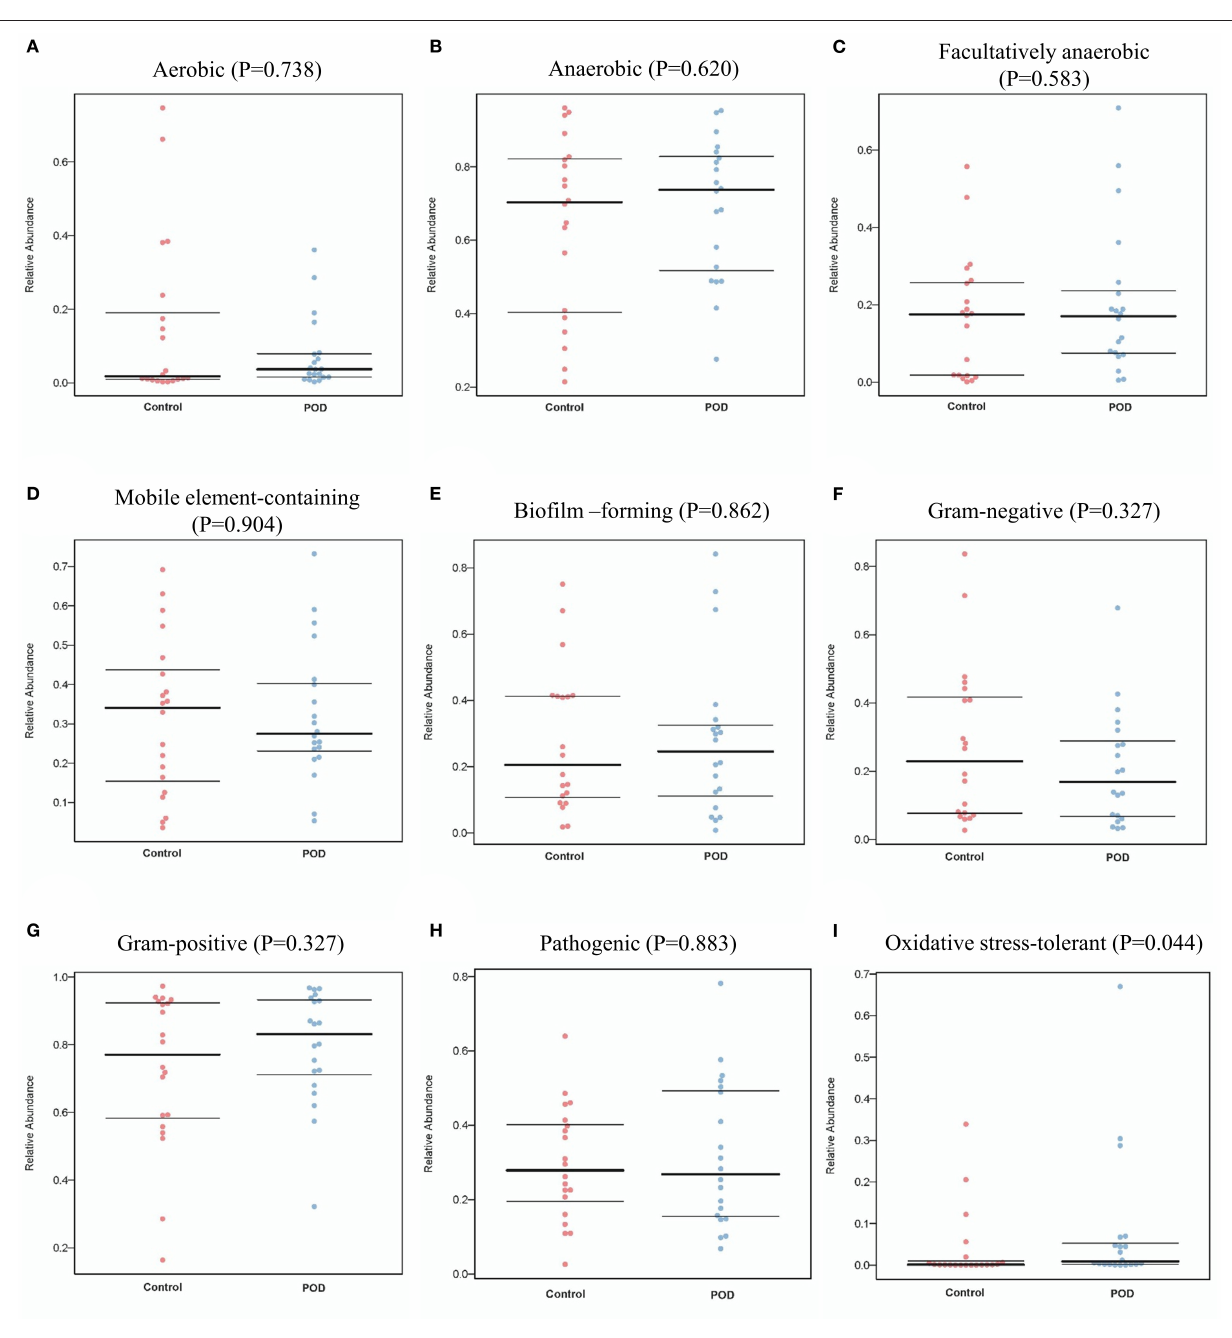
results are partly consistent with our results and indicate that gut microbiota-induced psychological alterations are derived from a common bacterial cohort both in humans and